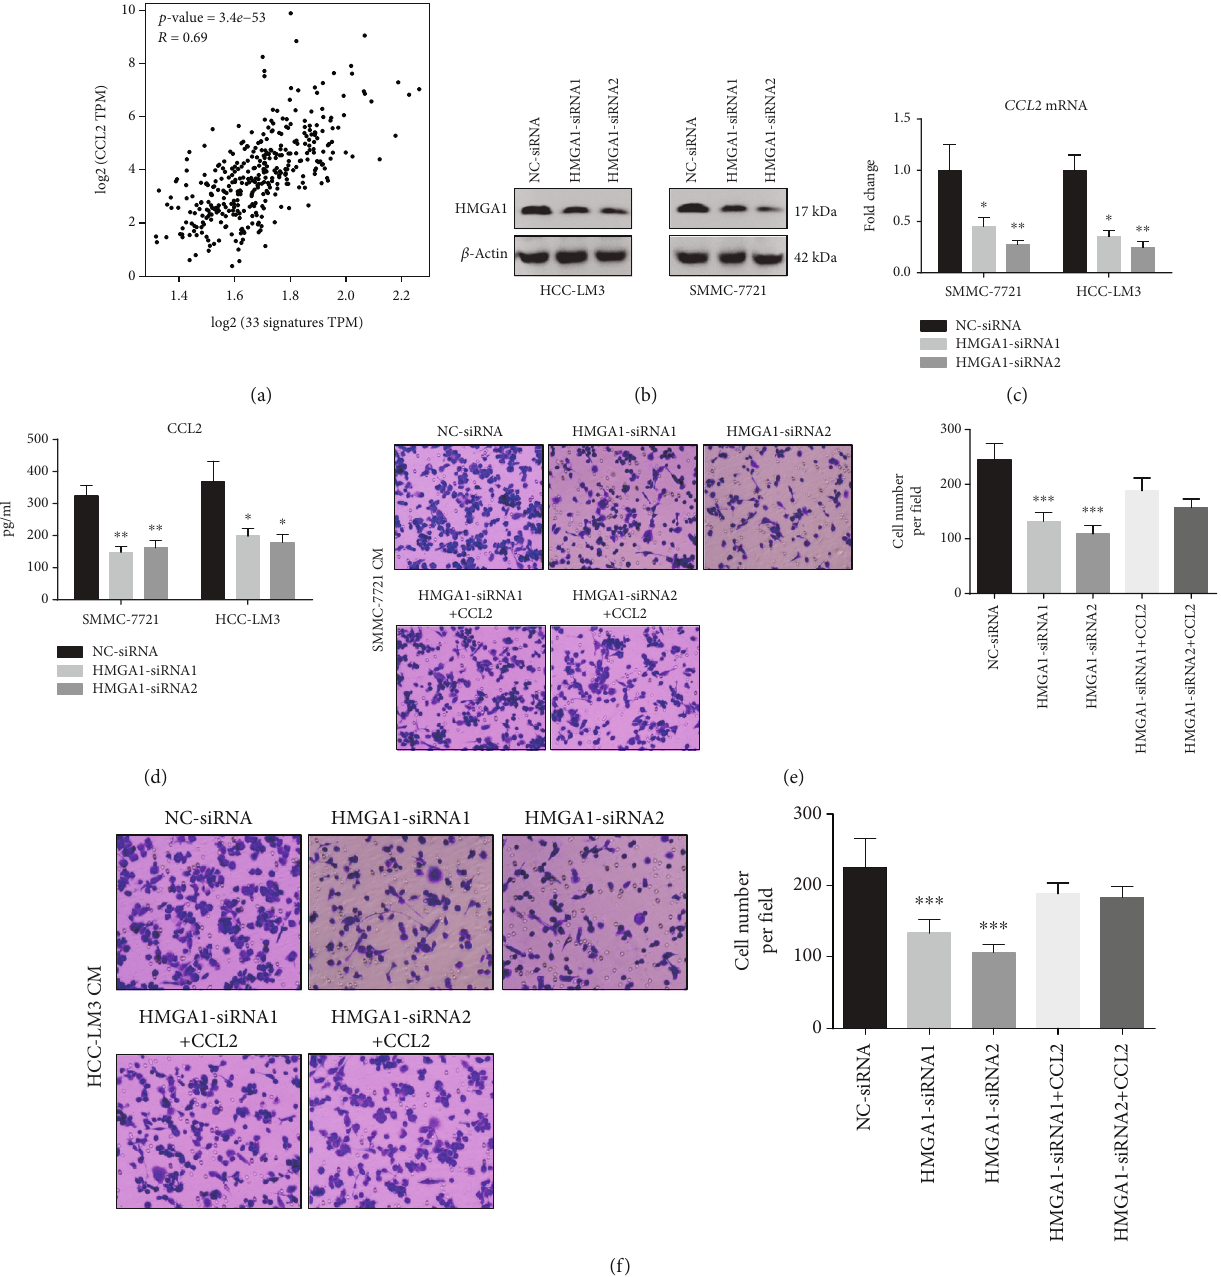
Figure 3: CCL2 is required for HMGA1-induced macrophage recruitment. (a) A gene signature consists of 33 genes (AIF1, CCL1, CCL14, CCL23, CCL26, CD300LB, CNR1, CNR2, EIF1, EIF4A1, FPR1, FPR2, FRAT2, GPR27, GPR77, RNASE2, MS4A2, BASP1, IGSF6, HK3, VNN1, FES, NPL, FZD2, FAM198B, HNMT, SLC15A3, CD4, TXNDC3, FRMD4A, CRYBB1, HRH1, and WNT5B) was used to de fi ne in fi ltrating macrophages, and the correlation between CCL2 and macrophage was investigated by Spearman ’ s analysis. (b) HCC-LM3 and SMC-7721 cells were transfected with two speci fi c siRNAs against HMGA1 or negative control (NC) siRNAs, and Western blotting analysis showed the protein level of HMGA1 in the HCC-LM3 and SMC-7721 cells. (c) Real-time qPCR analysis showed the mRNA level of CCL2 in the HCC-LM3 and SMC-7721 cells transfected with NC-siRNA or HMGA1-siRNA1/2. (d) Enzyme-linked immunosorbent assay (ELISA) showed the secreted level of CCL2 in the conditioned medium (CM) of HCC-LM3 and SMC-7721 cells transfected with NC-siRNA or HMGA1-siRNA1/2. (e and f) HCC-LM3 and SMC-7721 cells were treated with NC-siRNA or HMGA1- siRNA1/2 for 48h, and CM was acquired and subjected for Transwell assay; the migratory ability of human monocytes isolated from PBMCs was evaluated after stimulation with indicated CM and recombinant human CCL2 protein for 12h. The ANOVA followed by post hoc Tukey ’ s multiple comparison test was used for group comparisons. ∗ P < 0 : 05 ; ∗∗ P < 0 : 01 ; ∗∗∗ P < 0 : 001